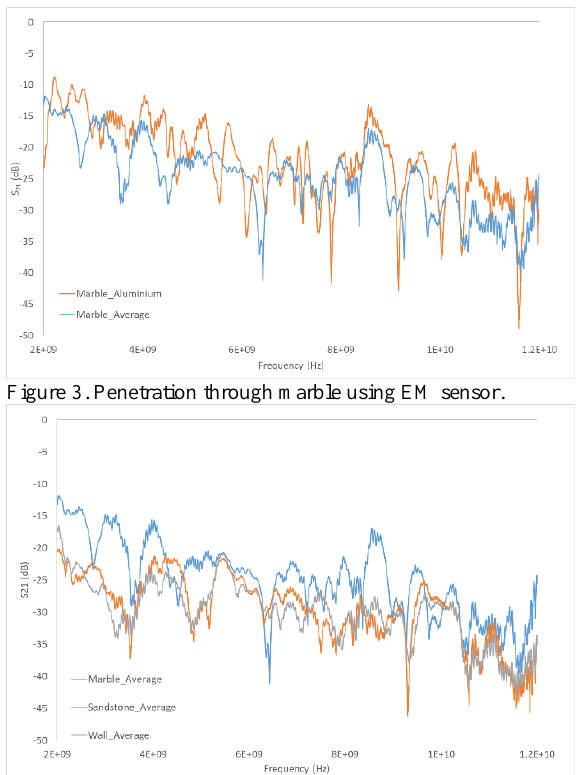
Figure 4. Electromagnetic response for different building